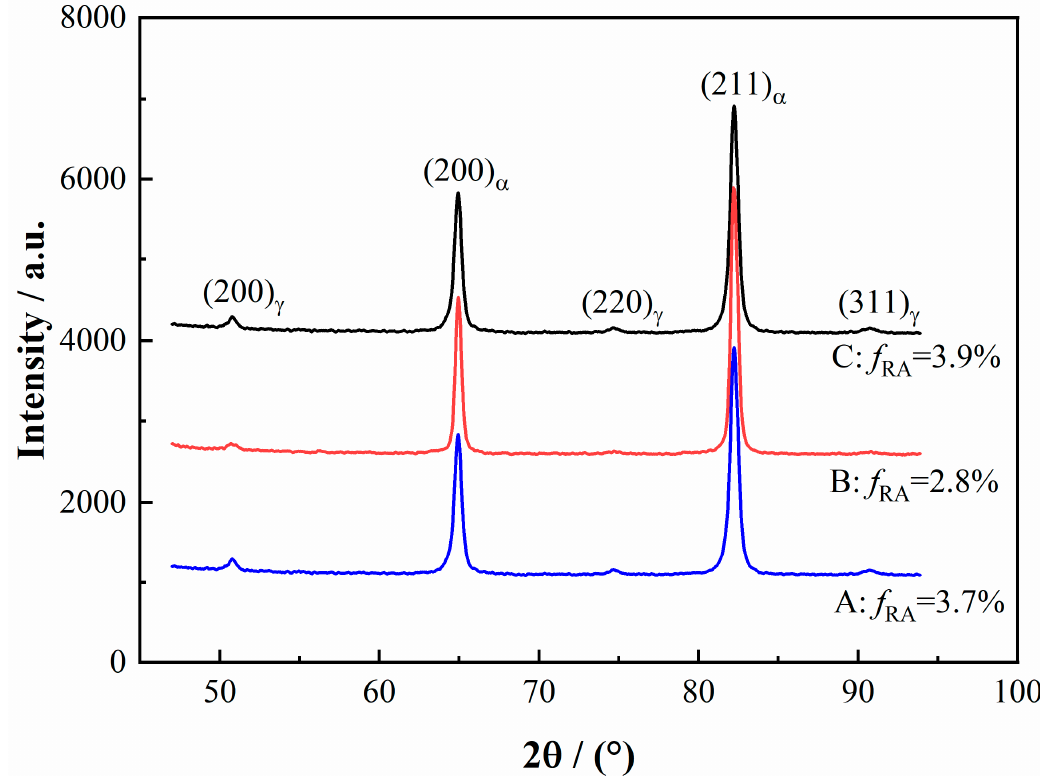
Figure 2. XRD spectra illustrating different volume fractions of retained austenite in specimen A, B, and C.